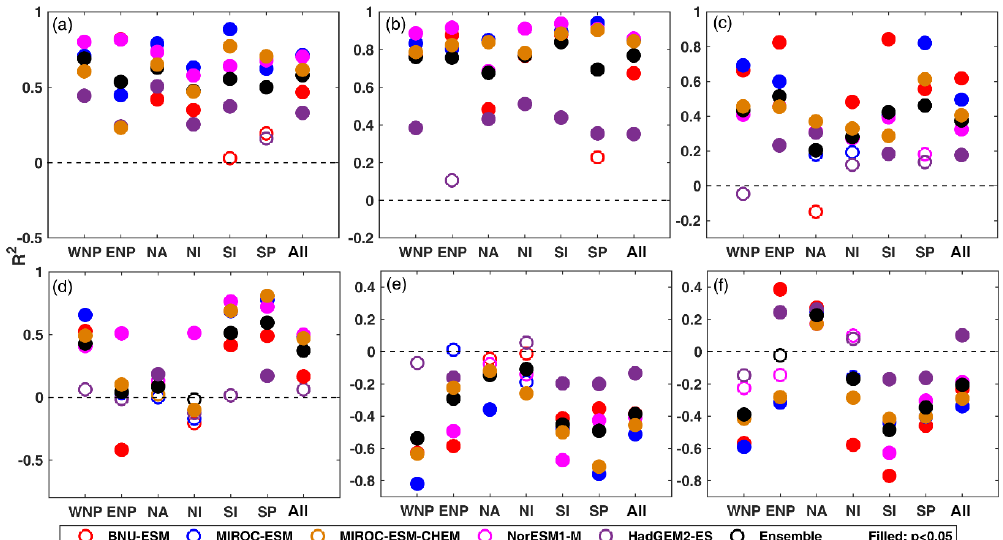
Figure 7. The correlations ( R 2 ) between differences (G4 − RCP4.5) during TC season and across the six TC basins for the years 2020–2069 for (a) V pot anomalies as a function static stability T s − T o . Panels (b) – (e) show R 2 coefficients for anomalies with sea surface temperature differences ( T s ) and (b) V pot , (c) GPI, (d) relative humidity, and (e) vertical wind shear. Each model is weighted equally in the ensembles regardless of number of